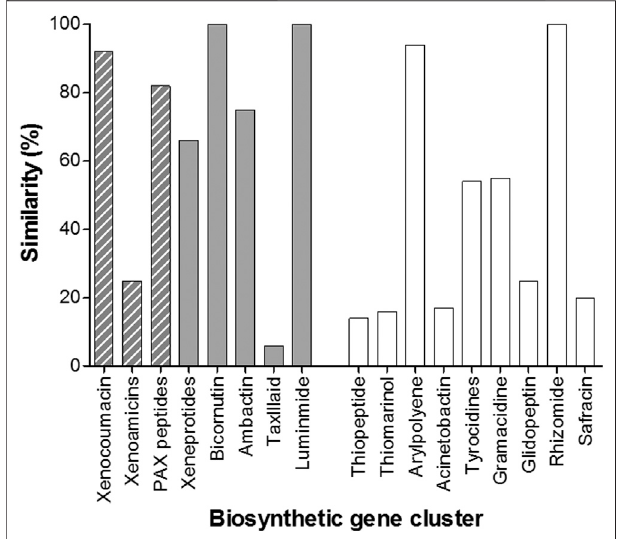
FIGURE 5 | Graph depicting the various operons identi fi ed in the whole genome of X. khoisanae J194 by the antiSMASH algorithms. The gray bars indicate operons native to Xenorhabdus bacteria. Operons for xeneprotides, bicornutin, ambactin, taxlllaid and luminmide were also detected by antiSMASH,butwasnotidenti fi edinthecrudeextracts.Thegrayhashedbars indicate detected secondary metabolite products related to the expression